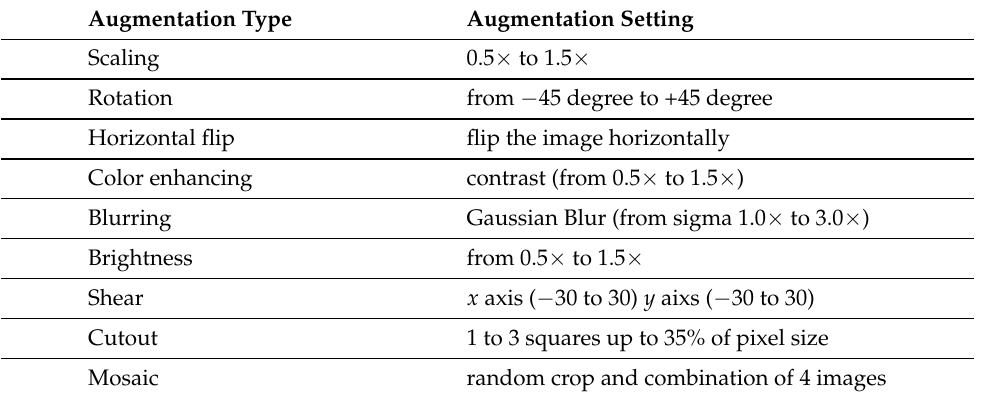
Figure 7. Data-augmentation example. ( a ) Original image. ( b ) Flip. ( c ) Shear. ( d ) Scale. ( e ) Contrast. ( f ) Rotation. ( g ) Cut out. ( h ) Brightness. ( i ) Blur. ( j ) Mosaic. Table 2. Augmentation type and